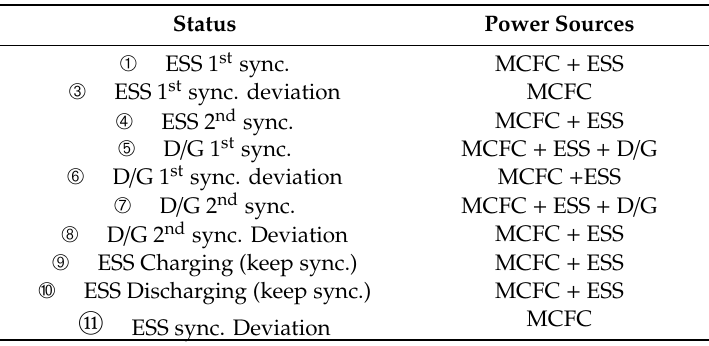
Figure 15. Synchronization and system deviation for load pattern of normal seagoing case 3. Table 8. Synchronization condition in normal seagoing case Table 8. Synchronization condition in normal seagoing case 3.